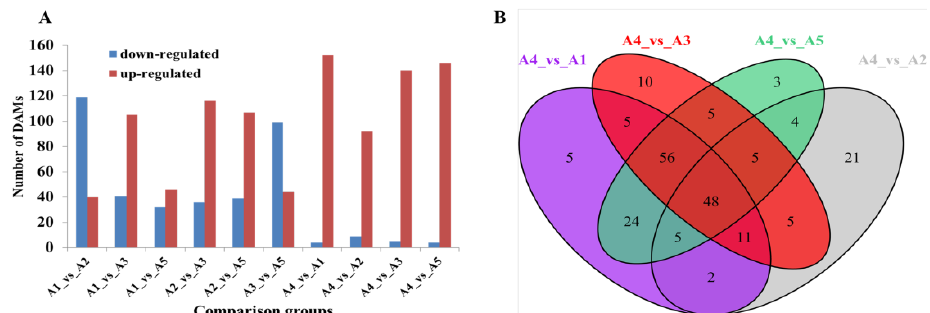
Figure 5. Differential flavonoid analysis among the five eggplant varieties. ( A ) Number of differ- entially accumulated flavonoids among the five eggplant varieties; ( B ) Venn diagram showing the overlapping and cultivar-specific differential metabolites among the comparison groups, including A4 vs. A1, A4 vs. A2, A4 vs. A3, and A4 vs. A5.